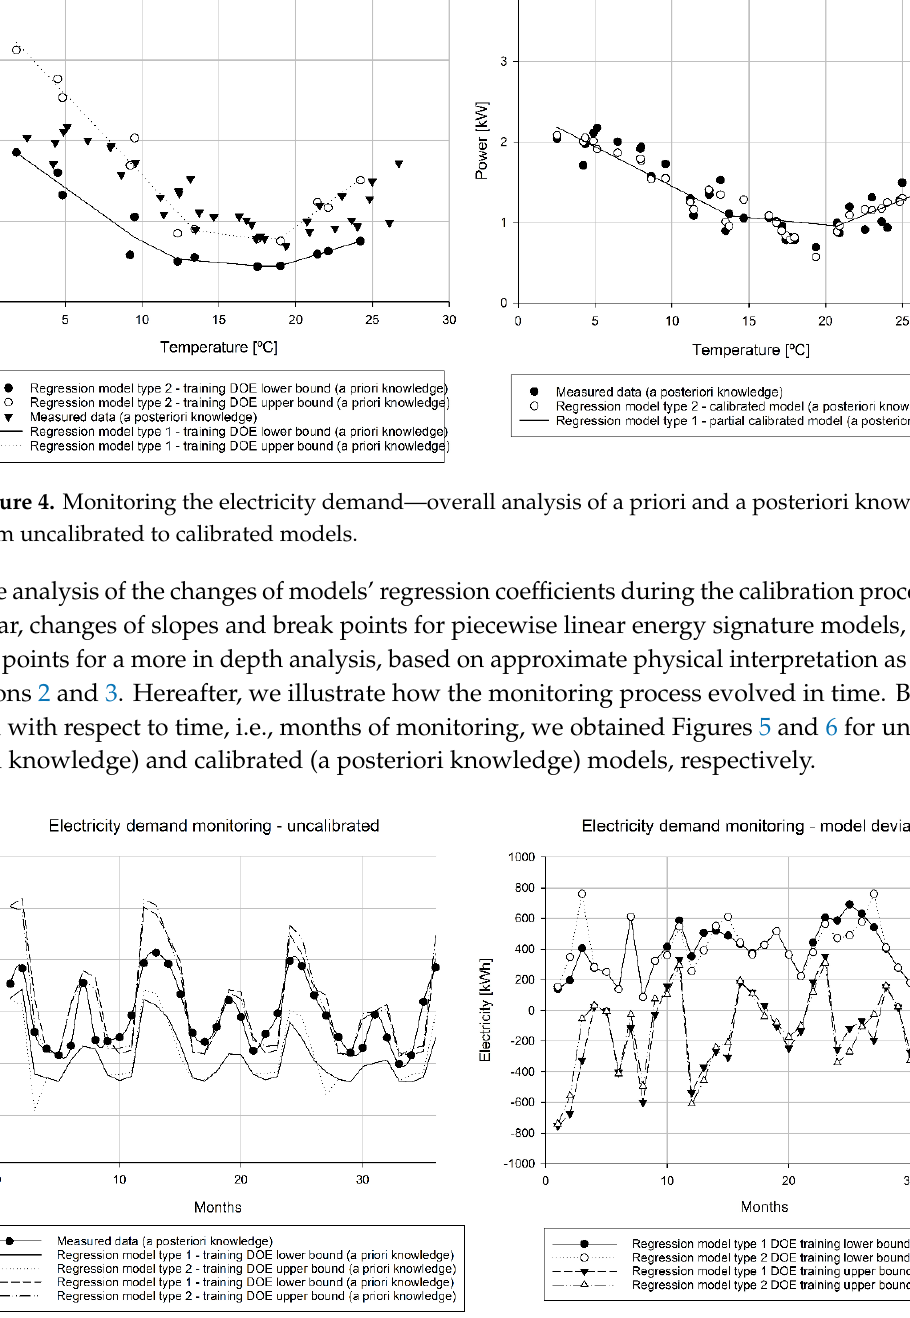
Figure 6. Electricity demand monitoring—comparison of measured data, partial calibrated regression model type 1, calibrated regression model type 2 and deviations between measured and predicted data. As reported in Table 7, the calibrated models were trained on the first two years of data and then tested on the third year of data (36 months of the total monitoring period). In Figure 5 we could observe the evolution of building performance in time with respect to our (pre)established performance boundaries, while in Figure 6 we could verify how measured data and calibrated (or partially calibrated in the case of type 1) models data reasonably overlaps on a monthly base. On the right side of both Figures 5 and 6, the deviations between measured and predicted data are plotted. Deviations in Figure 5 indicate that, at many points in time, the building had an energy consumption near to the upper bound of simulated electricity consumption while, in just a few points in time, it has an energy consumption near to the lower bound of simulation. Finally, in Figure 6 the deviations between measured and predicted data exhibited a pattern in time (similar for both types of models). Variations can depend on multiple factors and, among them, on behavioural change of occupants that may have determined different values of internal gains